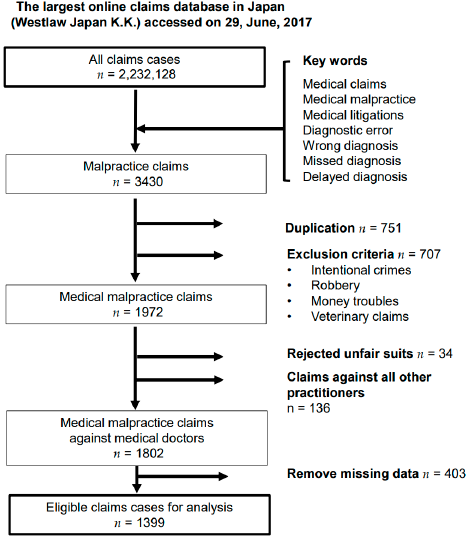
Figure 1. Flowchart of participant selection for the analysis.